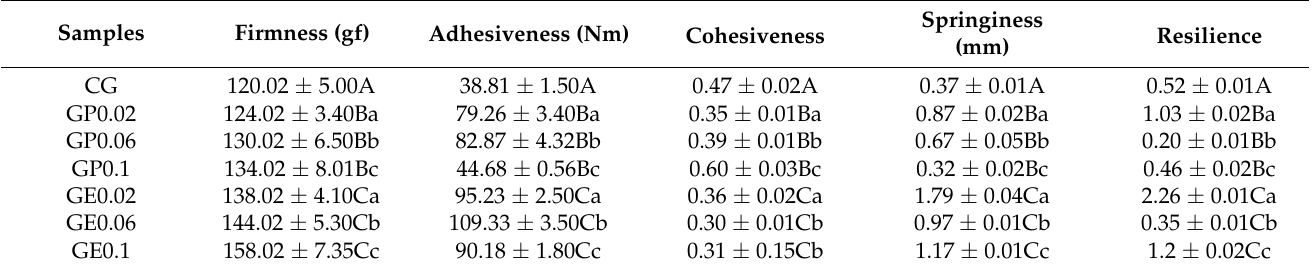
Table 2. Textural properties of